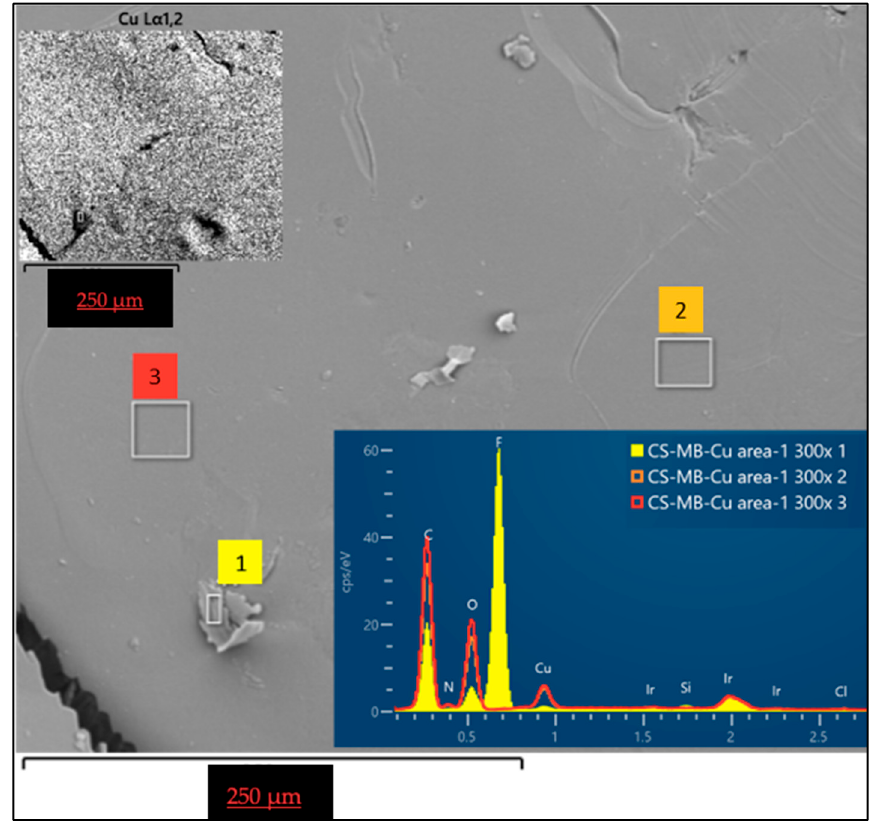
Figure 10. EDS image of spent CS-MB. Area 1 is identified as an artifact in this EDS image.